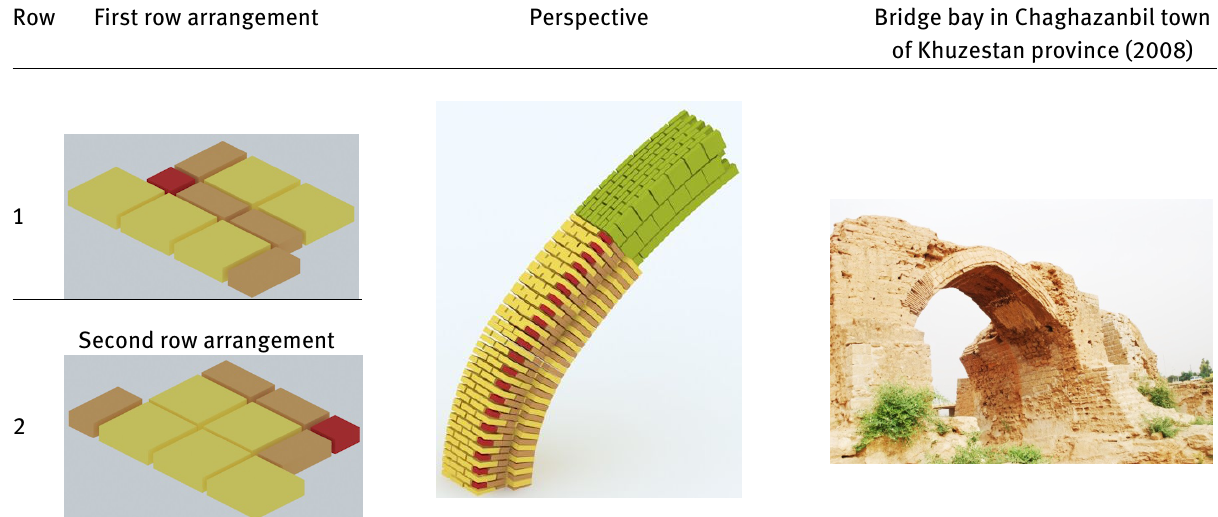
Table 5: Perspective and photo of masonry rib implementation using explicit mixed method Row First row